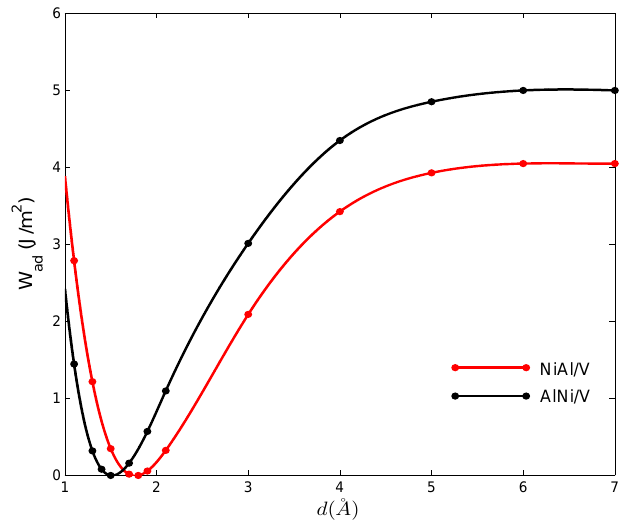
Figure 2. The work of adhesion of the NiAlV and AlNiV interface systems.